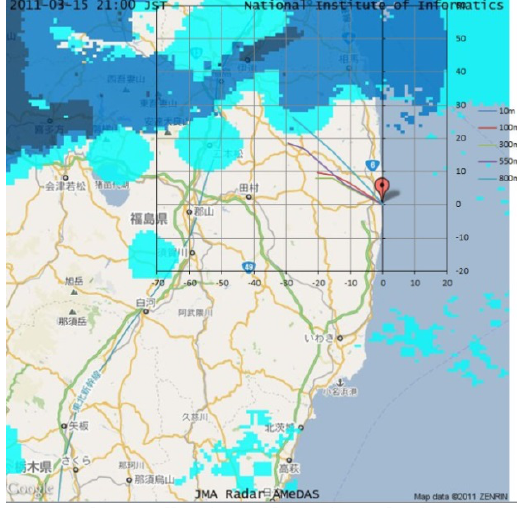
Figure 4. Flying polluted particles and rainclouds at 21:00 on March 15.